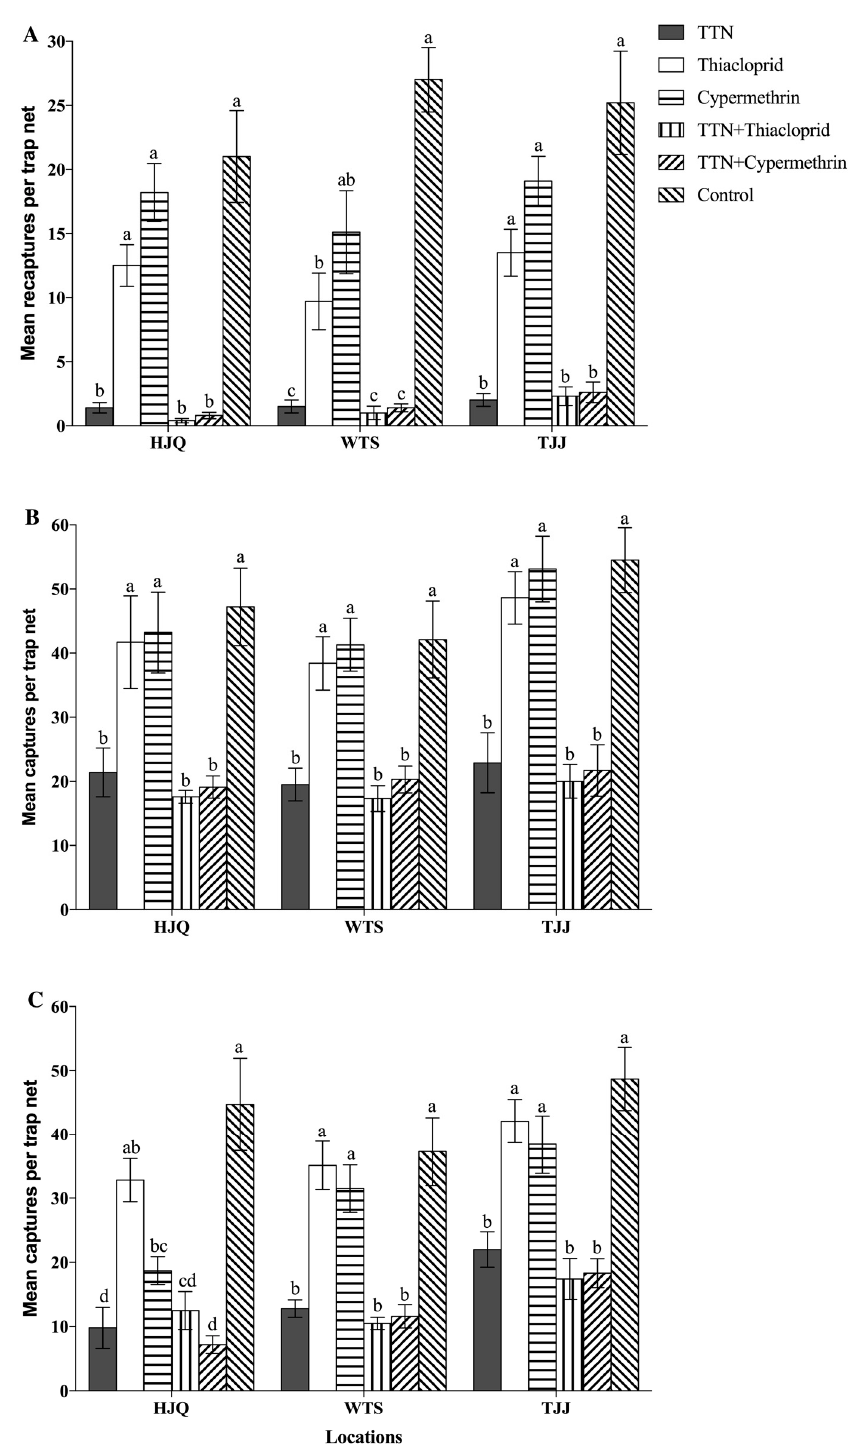
Figure 3. The number (means ± SE) of tree-of-heaven root weevils (TRW), Eucryptorrhynchus scrobiculatus, caught per monitoring trunk trap net (MTTN) on trees that were either untreated or treated with the trunk trap net (TTN), insecticide (thiacloprid or cypermethrin) sprays, or their combination at Haojiaqiao (HJQ), Wutongshu (WTS), and Taojiajuan (TJJ). ( A ) The number of captured and marked TRWs in 2016. ( B ) The number of captured wild TRWs in 2017. ( C ) The number of captured wild weevils in 2018. Columns with the same letter were not significantly different (Tukey’s HSD, α = 0.05).